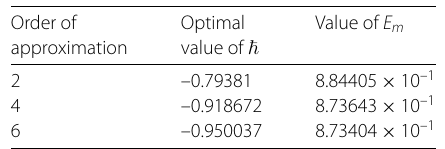
Table 4 Optimal value of (cid:2) for λ =